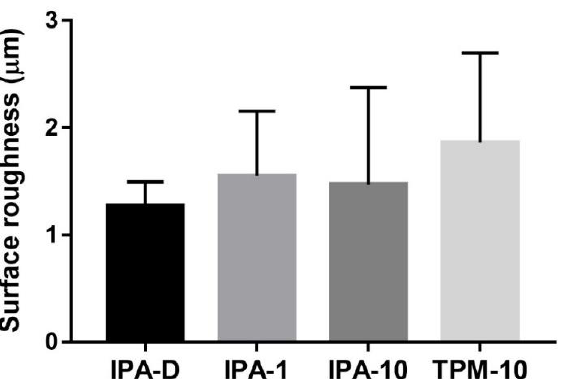
Figure 2. Surface roughness according to different washing conditions.